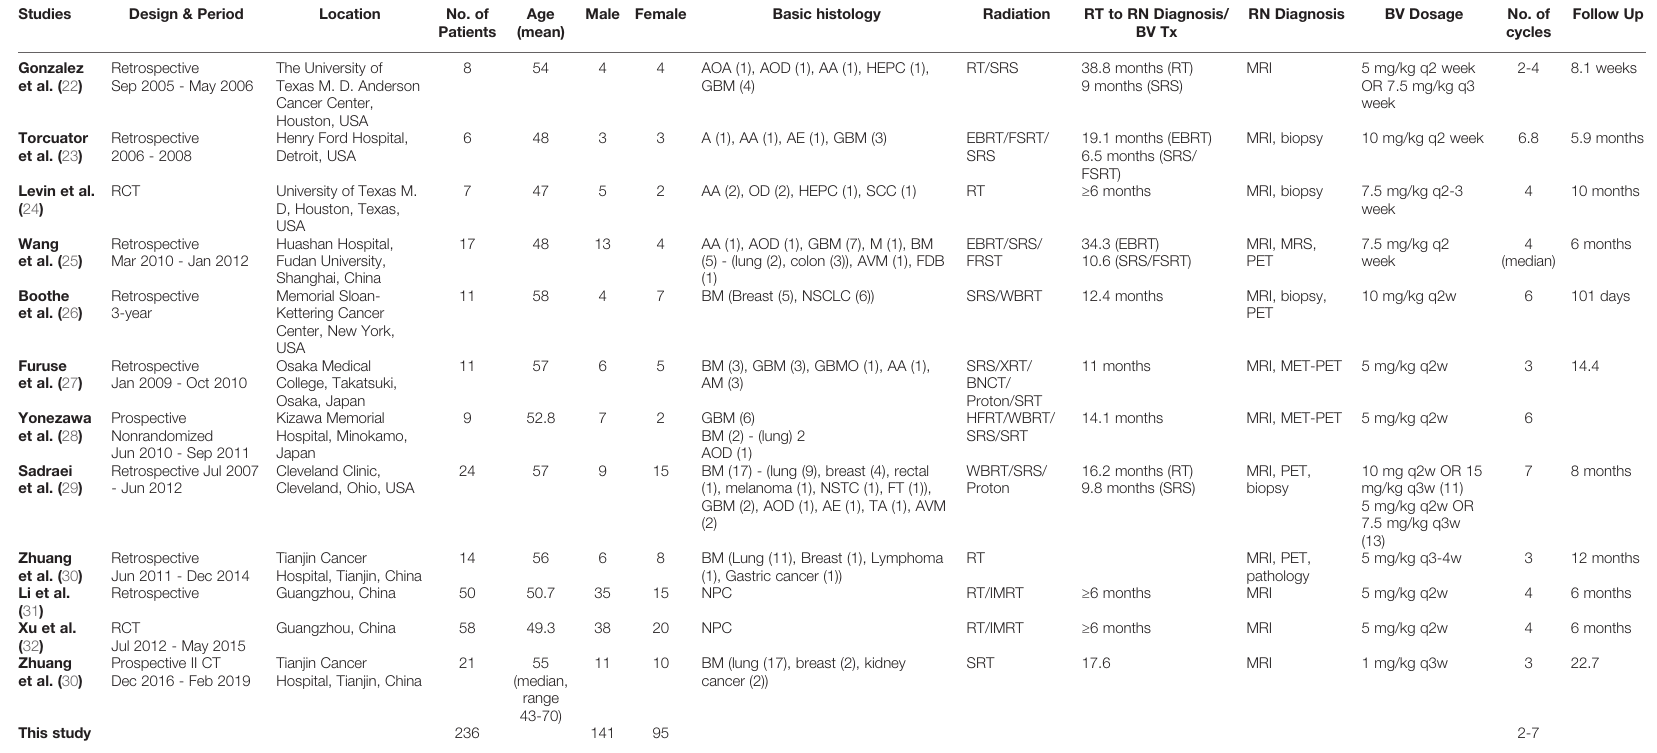
TABLE 1 | General characteristics of studies and participants.